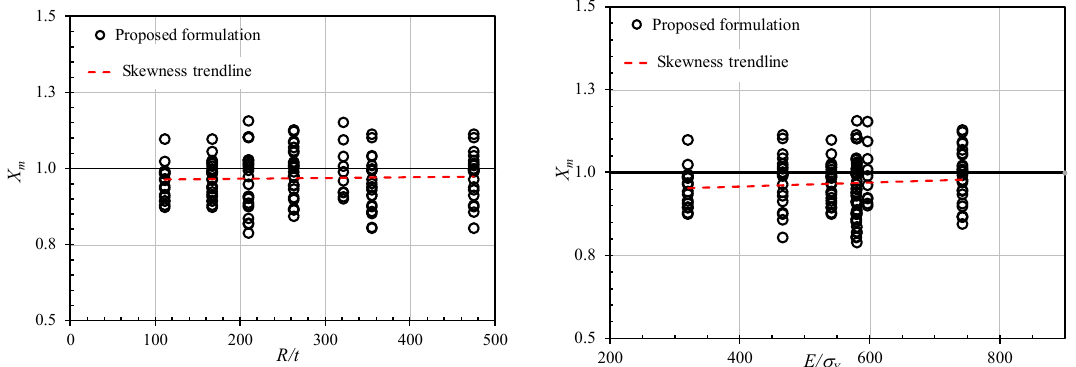
Figure 26. Skewness of the proposed formula against the basic parameters R/t and E/σ Y for the stringer-stiffened cylinder.